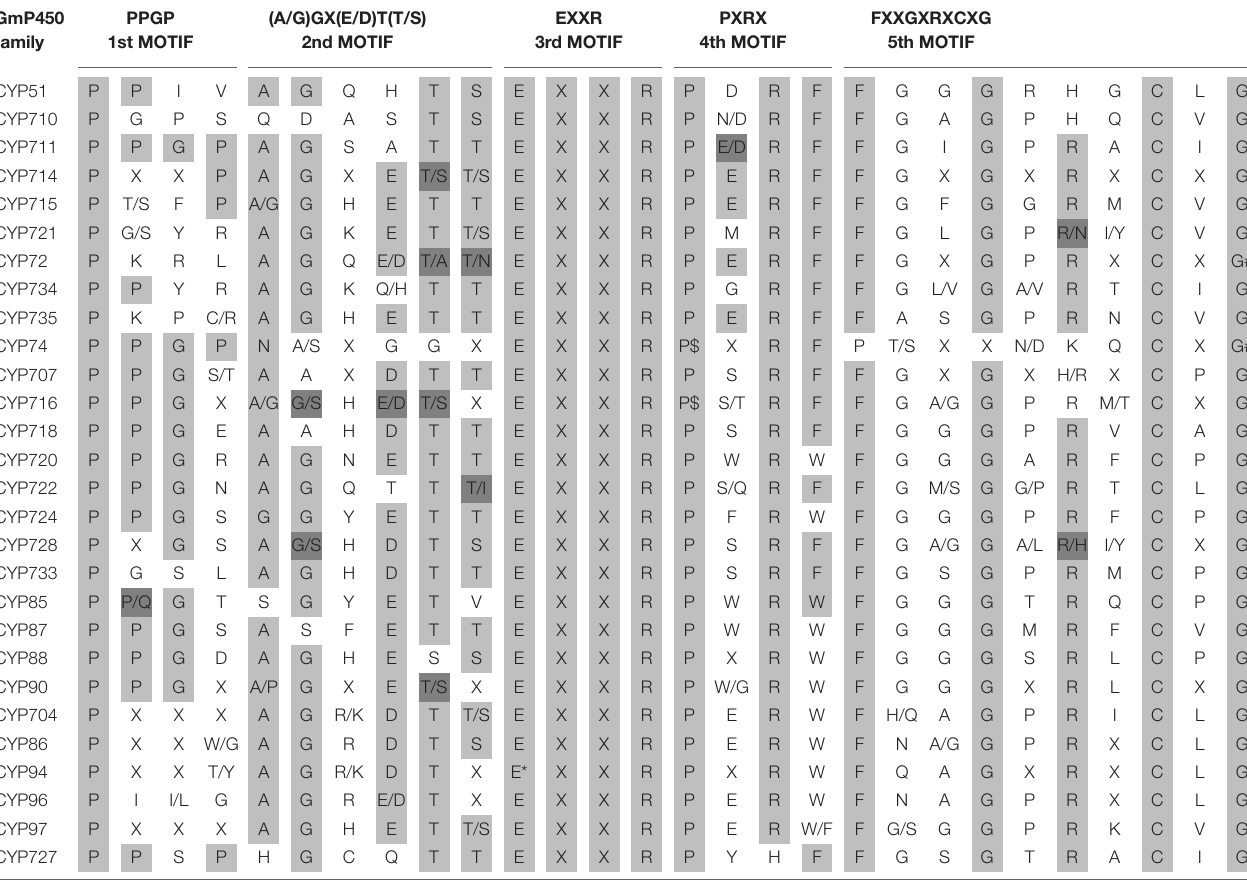
TABLE 2 | Conserved motifs present in non-A-type GmP450 families. GmP450 PPGP family 1st